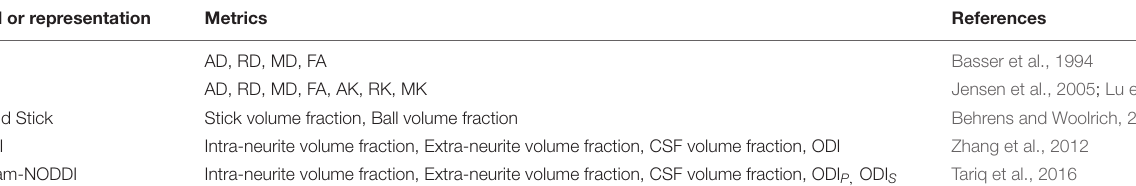
TABLE 2 | List of metrics from each model assessed in relationship to ground truth phantom metrics.